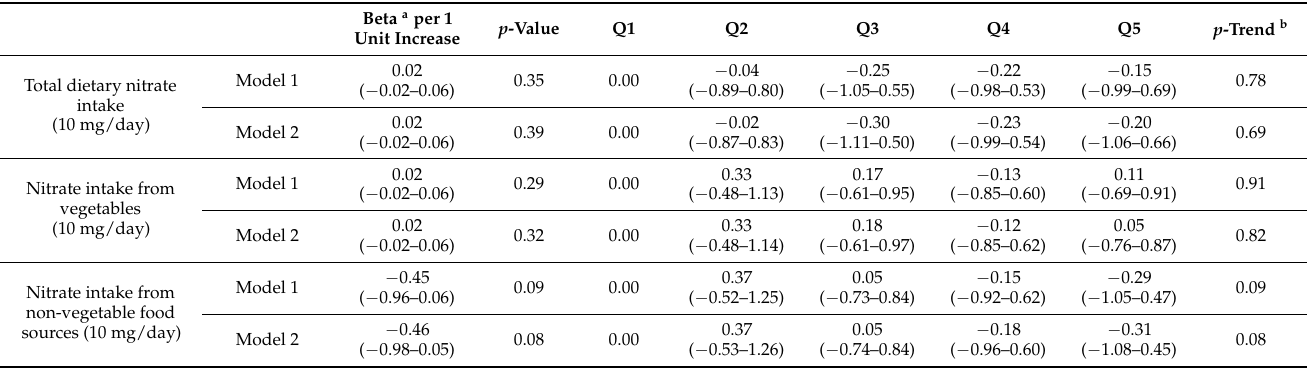
Model 1: adjusted for body mass index, total energy intake, diet quality, physical activity, and follow-up time. Model 2: model 1 additionally adjusted for education level and smoking status. a Betas (95%CI) for intraocular pressure (IOP) by total dietary nitrate intake, nitrate intake from vegetables, and nitrate intake from non-vegetable food sources (as continuous variables) analyzed using linear regression. b Test for trend conducted using median value for each quintile (total dietary nitrate intake: quintile 1 = 48.8 mg/day; quintile 2 = 69.0 mg/day;